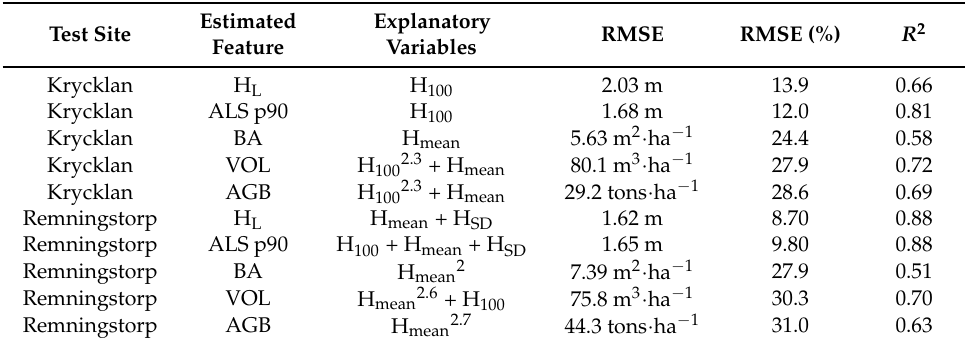
Table 6. Results estimated from height metrics. Subscript numbers represent height percentiles, while the mean denotes the average and SD the standard deviation.